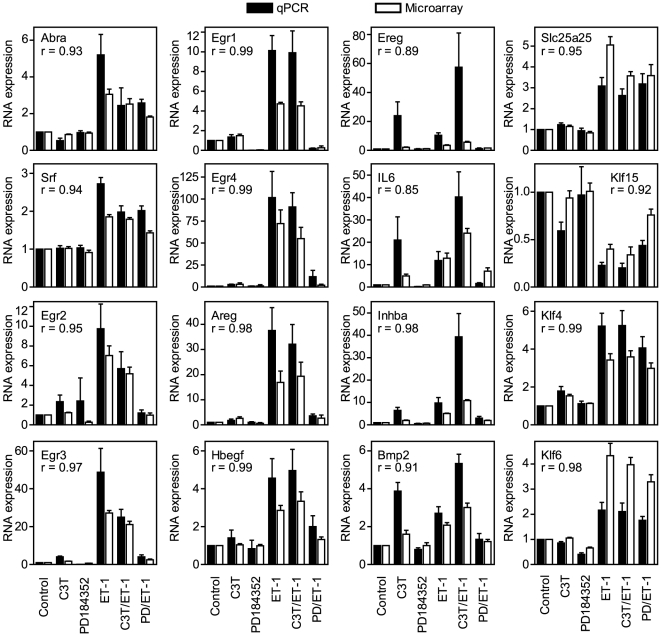
Comparison of qPCR and microarray data.Cardiomyocytes were unstimulated (Control) or exposed to ET-1, C3T, PD184352 or ET-1 together with C3T (C3T/ET-1) or PD184352 (PD/ET-1). ET-1 responsive mRNA expression measured by qPCR (see Figure 5 for detailed representations) was compared with the microarray data (solid bars = qPCR; open bars = microarray data). Results are relative to controls and are means ± SEM (n = 4 or 5). The linear regression coefficient is provided (r) for qPCR vs microarray data.